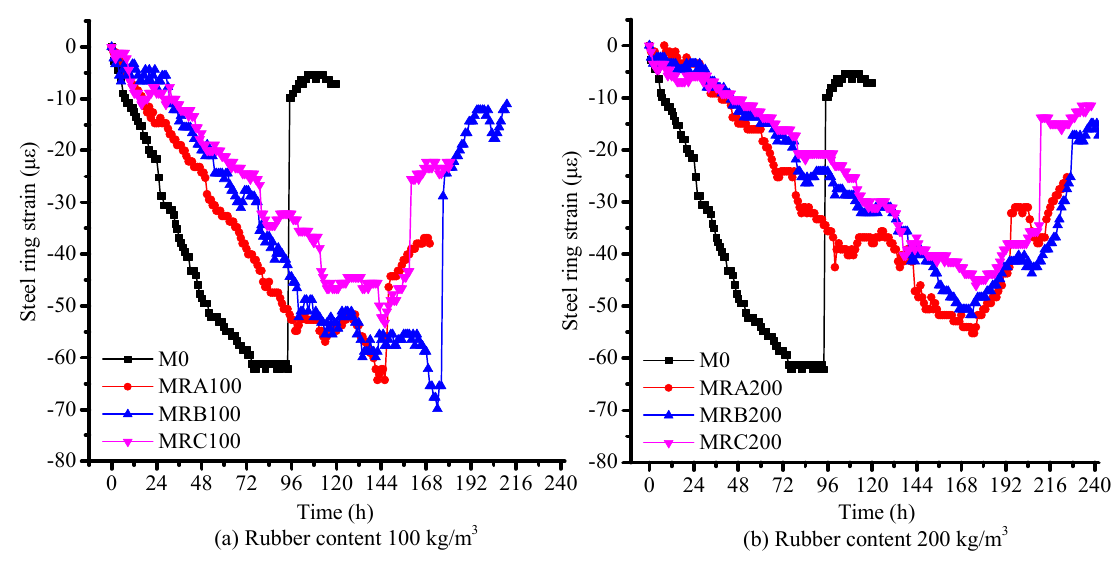
Figure 9. Strain obtained from the RRST. ( a ) Rubber content 100 kg / m 3 ; ( b ) Rubber content 200 kg / m 3 . Table 5. Compressive strength of mortars (MPa).